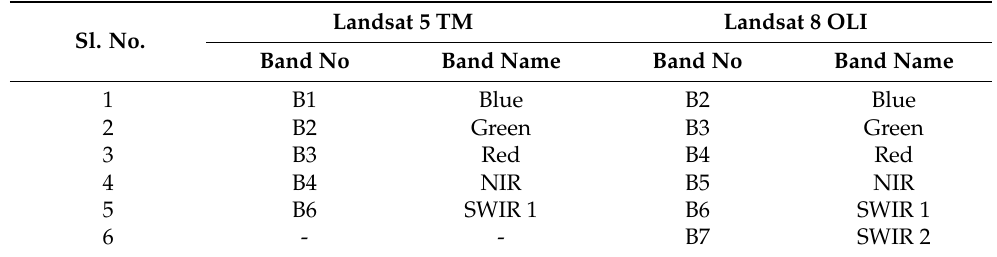
Table 3. List of spectral bands acquired from Landsat TM and OLI data regarding River course detection. Sl.